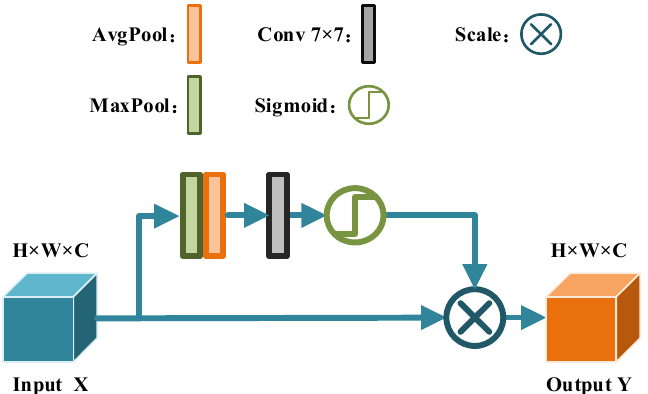
Figure 8. Spatial attention module (SAM). In the SAM, a maximum pooling and average pooling of the channel dimension are performed on the input feature map X to obtain two obtained channel descriptions. Splice these two descriptions together according to the channel. Then the features are nonlinearly transformed through 7 × 7 convolution and Sigmoid operation to generate attention weights. Finally, the attention weight is multiplied by the input feature map X to obtain the output feature map Y